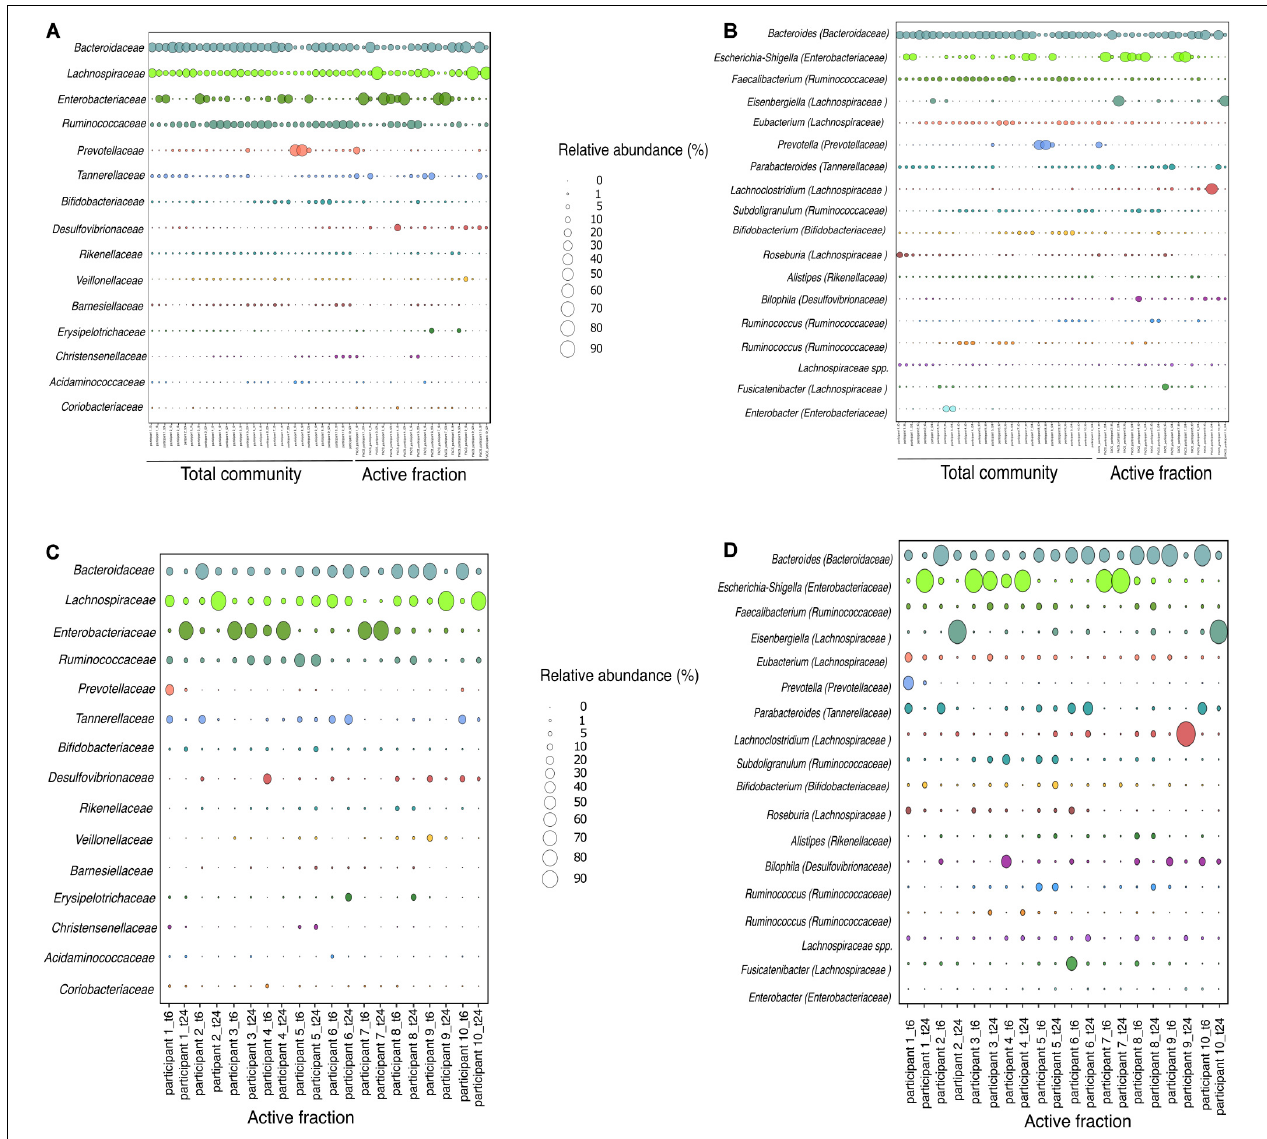
FIGURE 5 | Relative abundance of bacterial taxa based on 16S rRNA gene amplicon sequencing at family and genus level for each participant. (A,B) Relative abundance of the total community and the active fraction at time 6 and 24 h. (C,D) Relative abundance of the active fraction at time 6 or 24 h. Family and genera with relative abundance > 0.5 and > 1%, respectively, is